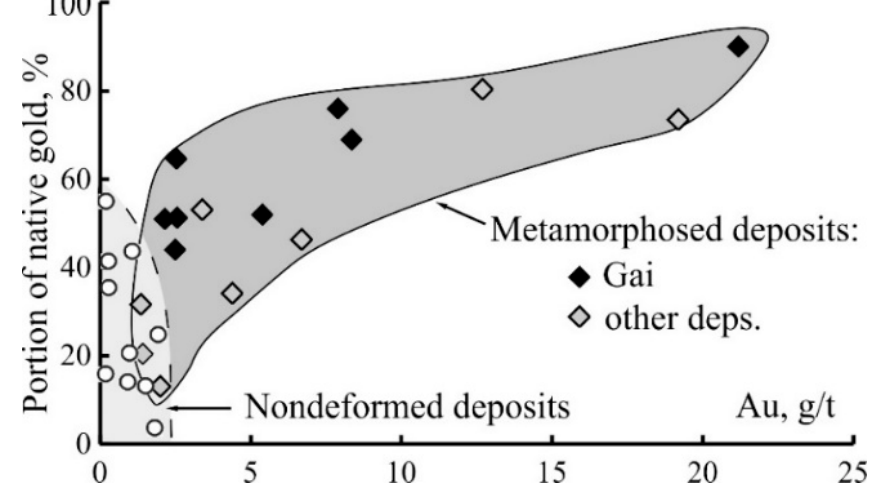
technological bulk probes; ( b ) gold fineness, microprobe data.